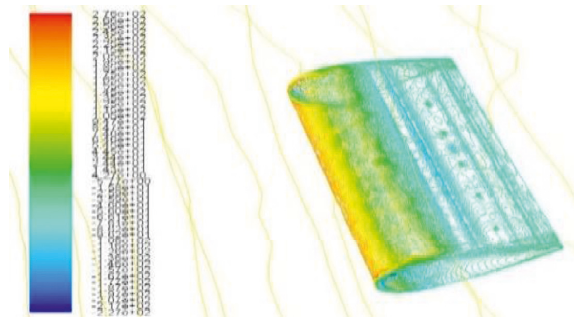
Figure 15: Total pressure at 15 ° AOA for the 3rd module.